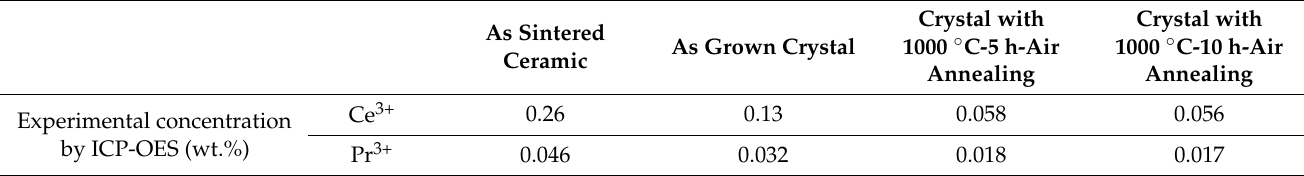
Table 1. The experimental activator concentrations of the as grown Ce, Pr:LuAG crystals and ceramics by ICP-OES